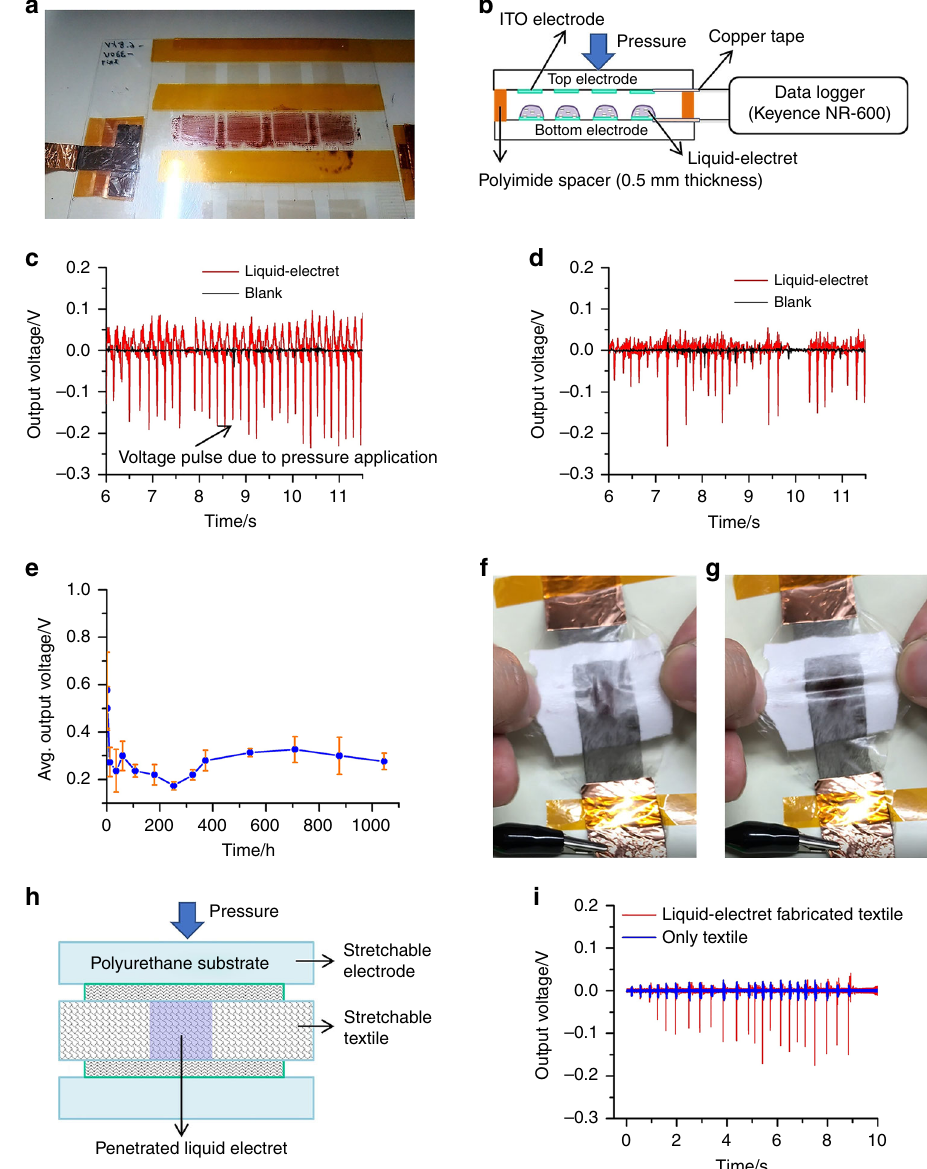
Fig. 5 Liquid electret characteristics exhibited by liquid porphyrin. a Photograph of the prototype liquid-electret device. b Schematic diagram of the cross- sectional view of the constructed liquid-electret device. c , d Output voltage characteristics of the liquid-electret device in its initial state ( c ) and after 7 days ( d ). e Decay graph of liquid-electret device showing the stability of average output voltage (V) on time scale (hour). The error bars represent the standard deviation of three measurements. f , g Photographs of the stretchable liquid-electret device prepared with a stretchable textile; before stretching ( f ) and after stretching ( g ). h Schematic diagram of the cross-sectional view of the stretchable liquid-electret device. i Comparison of output voltage characteristics of the stretchable liquid-electret device with textile in the presence and absence of liquid-electret